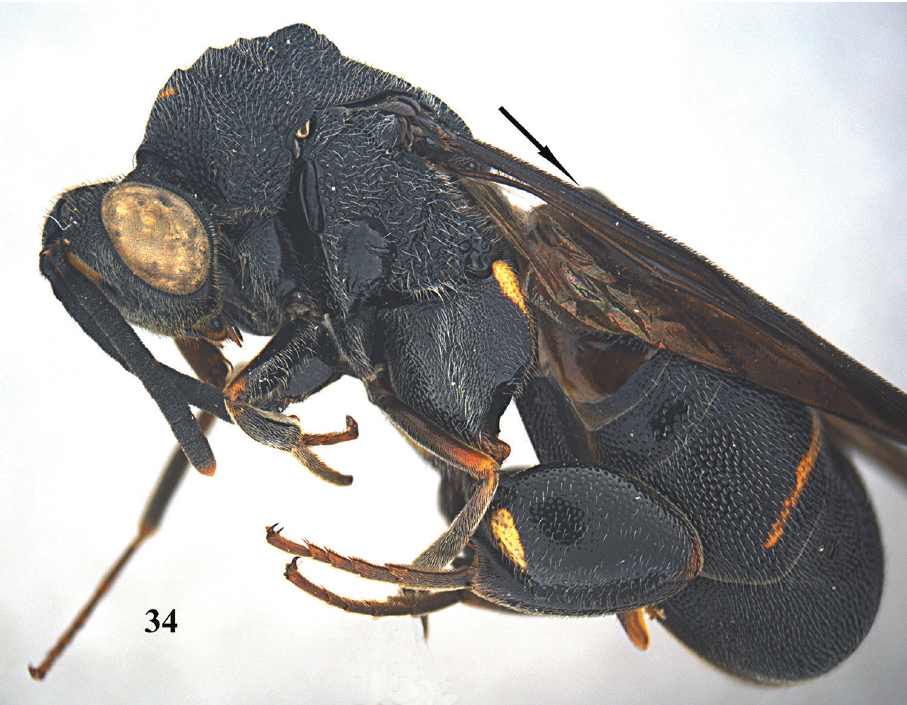
Figure 34. Leucospis aequidentata sp. n., ♀ , holotype, habitus